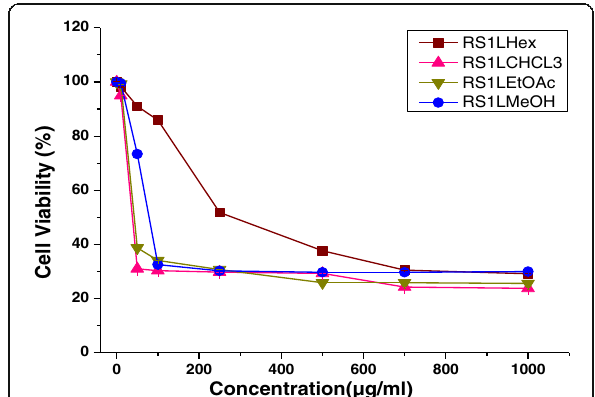
Fig. 4 Growth inhibitory activity of solvent extracts of Rhazya stricta leaves on NT2 cells. The cells were incubated with different concentrations for 48 h, and the cell viability was determined by the MTS assay. The percent inhibition was calculated in comparison to the vehicle control (0.01% MeOH) of two independent experiments. Abbreviations: Hexane extract of Rhazya stricta leaves (RS1L Hex), chloroform extract of Rhazya stricta leaves (RS1L CHCL3), ethyl acetate of Rhazya stricta leaves (RS1L EtOAc), and methanol extract of Rhazya stricta leaves (RS1L MeOH)